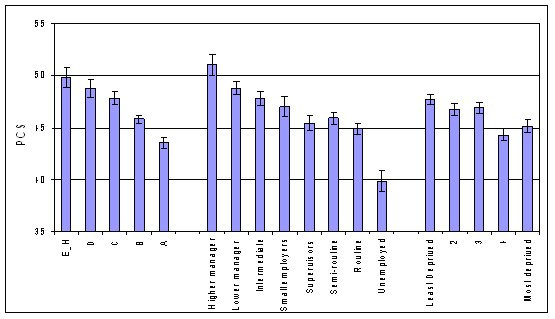
Physical (PCS) component summary mean scores with 95% confidence intervals by categories of CTVB, NS-SEC and fifths of the distribution of ward Townsend scores. Adjusted for age and gender.